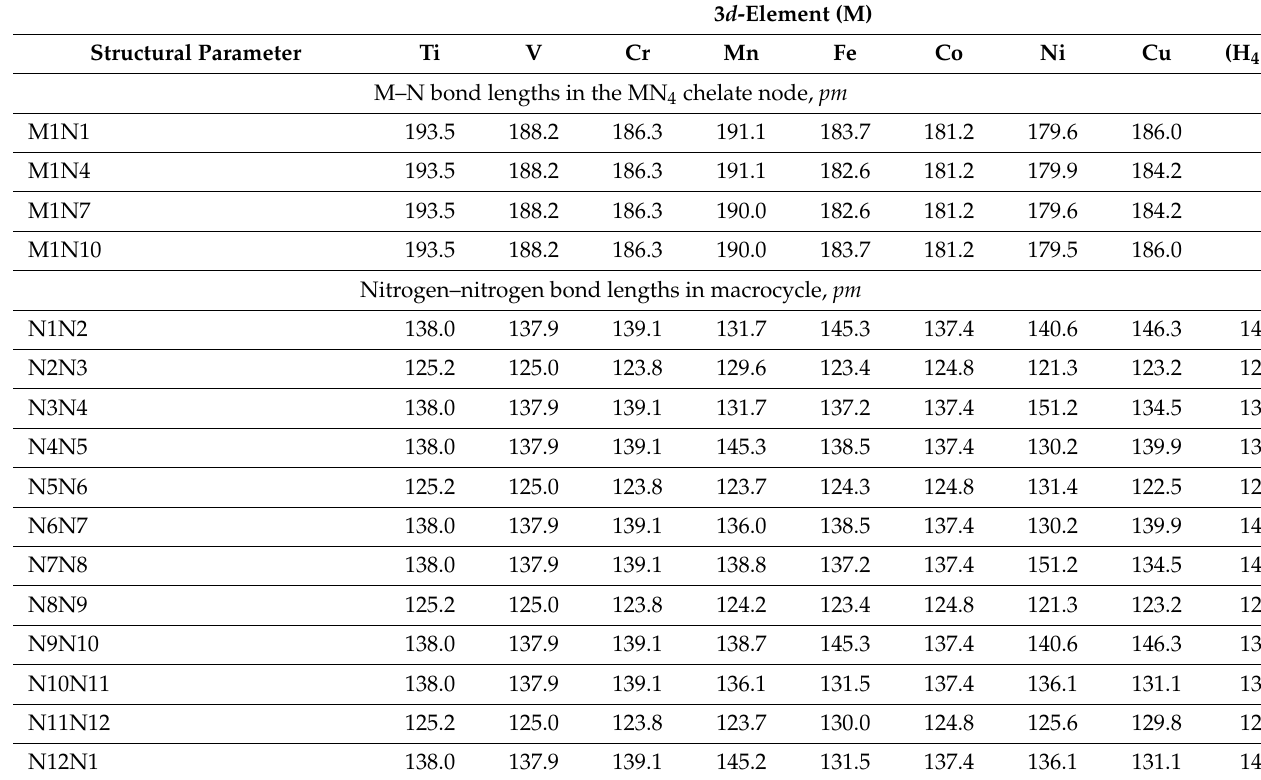
Table 1. Key parameters of molecular structures of M(N 12 ) compounds calculated by DFT M06/TZVP